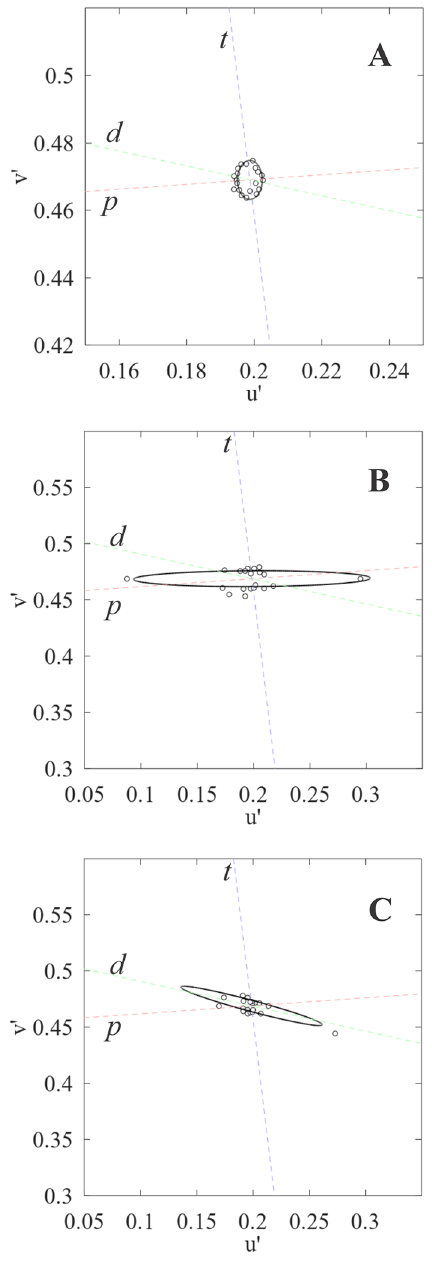
Figure 2. Chromatic discrimination ellipses from a normal trichromat (A) , and participants with CVD having protan defect (B) and deutan defect (C) . Circles represent chromatic discrimination thresholds at 20 chromatic axes. Dashed lines represent protan ( p ), deutan ( d ), and tritan ( t ) confusion